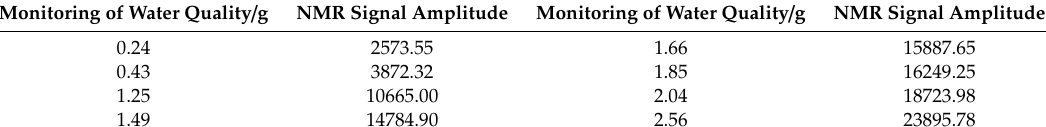
Table 3. Nuclear magnetic resonance (NMR) signal quantitatively calibrates the experimental data.